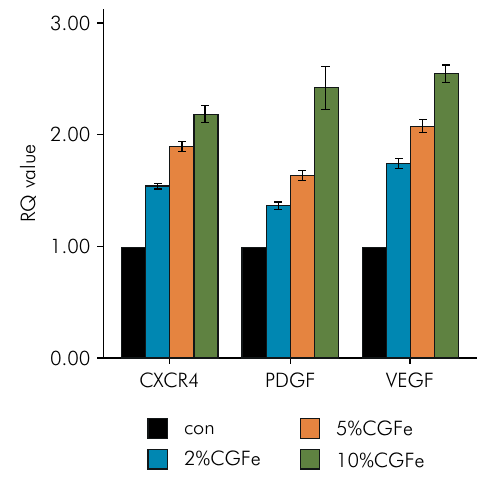
Figure 4. Expression levels of CXCR4, PDGF and VEGF after 24 h of culture. The mRNA expression levels of DPCs were evaluated by RT-PCR. The expression levels of CXCR4 and VEGF were normalized to the GAPDH expression. The results showed a rising trend in the 2% CGFe, 5% CGFe and 10% CGFe groups compared with the control group. All data are presented as the mean ± SE of three independent